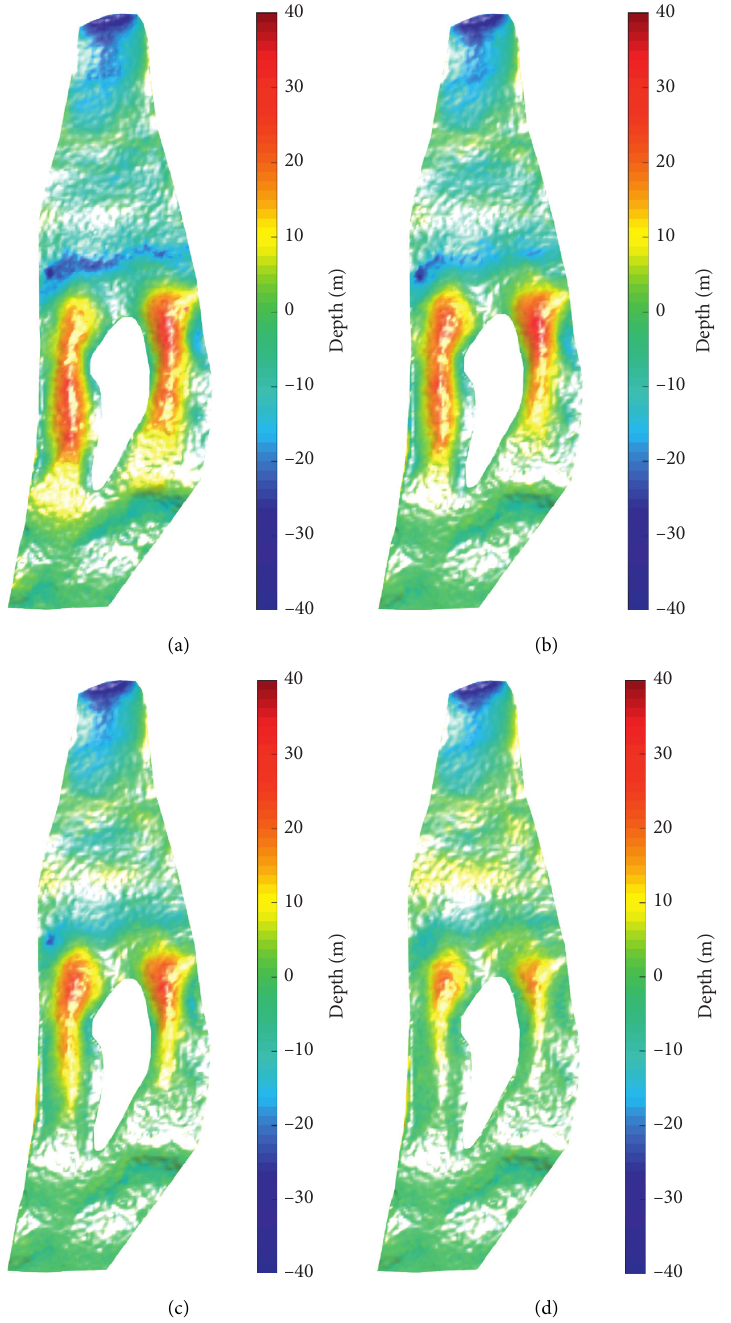
Figure 16: Distribution of scraping depth and deposit thickness under different internal friction coefficients. (a) μ (c) μ i � 0 . 47. (d) μ i � 0 .